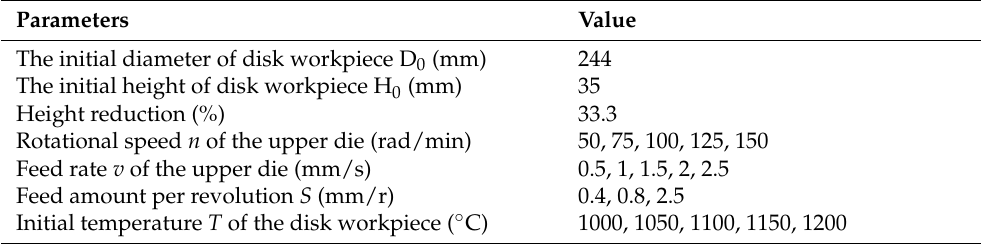
Table 3. Processing parameters of 3D numerical of disk of double-roll rotary forging.